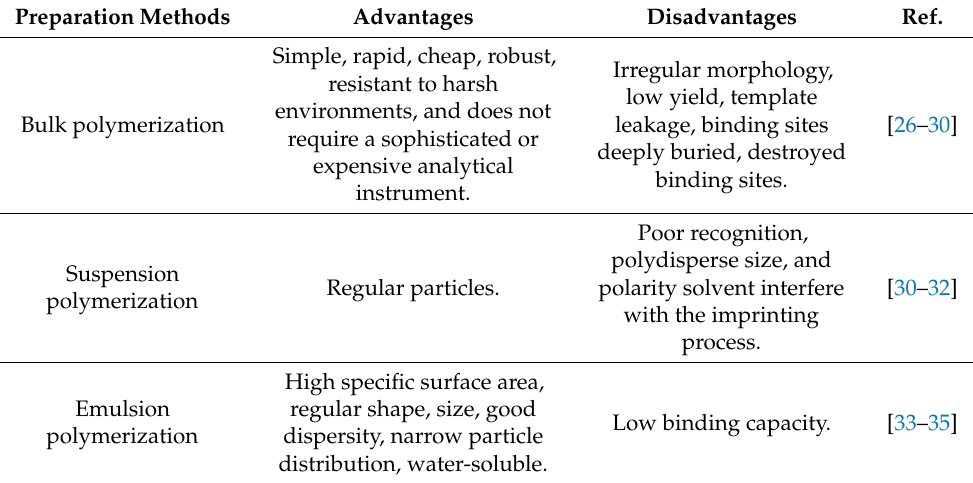
Table 1. The advantages and disadvantages of MIP preparation methods.